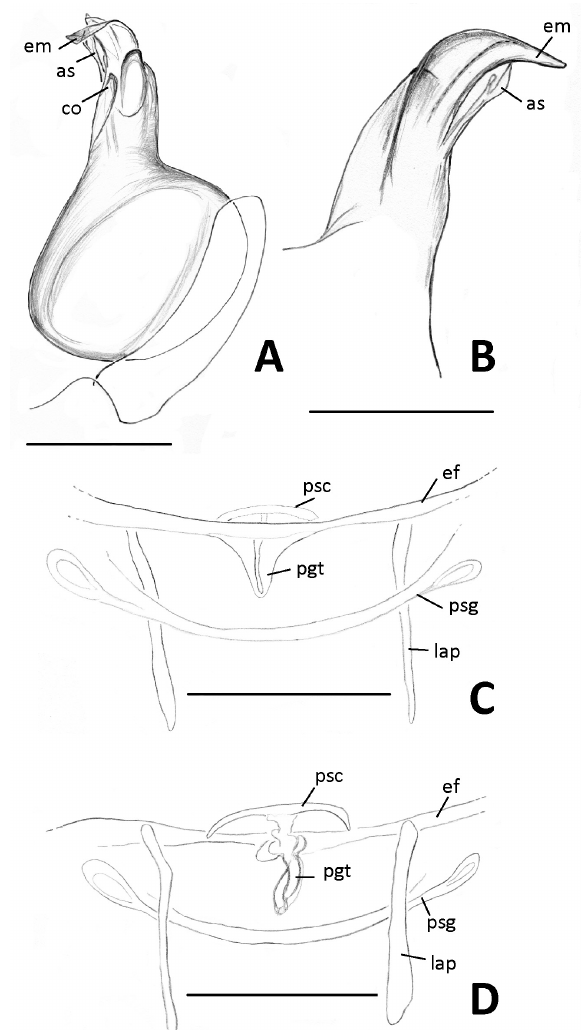
Figure 15. Pelicinus tumpy n. sp., from Mihinthale FR: A , male left palp, retrolateral view; B , details of the distal part of the bulb; C , female epigastric region, dorsal view; D , female epi- gastric region, ventral view. Abbreviations: as , accessory struc- ture; co , conductor; em , embolus; ef , epigastric furrow; lap , lat- eral apodemes; pgt , posterior genitalic tube; psg , posterior spiracular groove; psc , paddle-like sclerite. Scale bars: 0.1 mm.